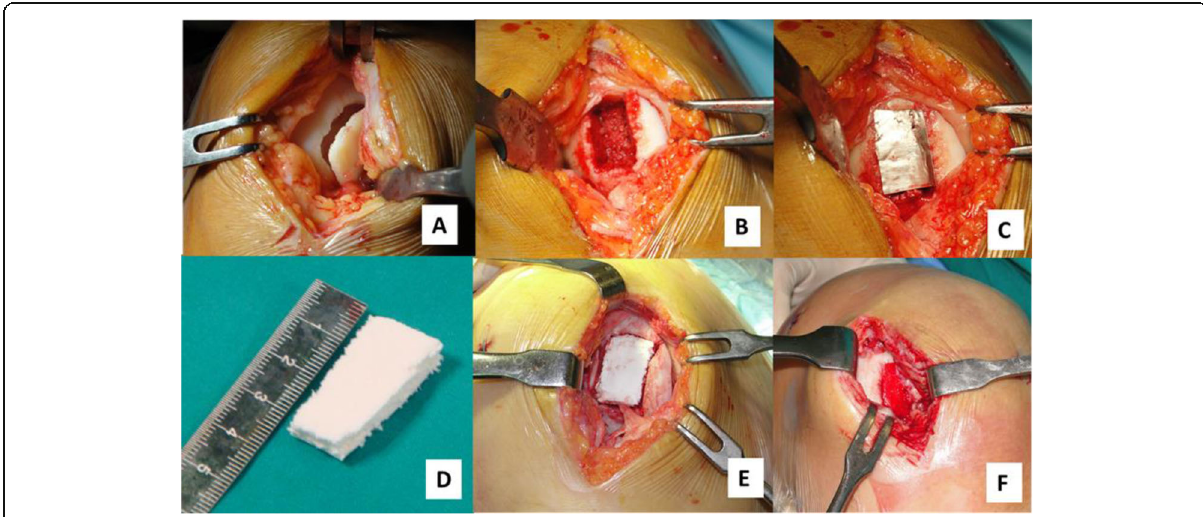
Fig. 1 Surgical technique of biomimetic scaffold implantation in a medial femoral condyle osteochondral lesion. a Lesion exposure; b Implant site preparation (regular box-shape 9 mm deep); c Templating; d Scaffold sizing; e Press-fit implantation; f Bleeding from subchondral bone after tourniquet removal